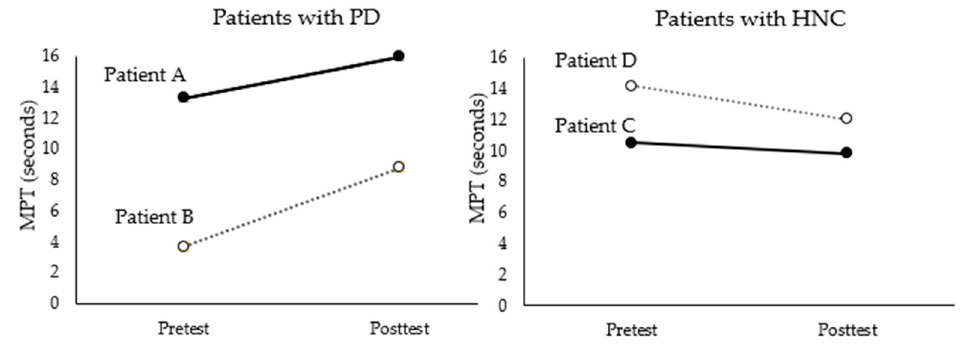
Figure 1. Results of MPT before and after intervention for each patient.